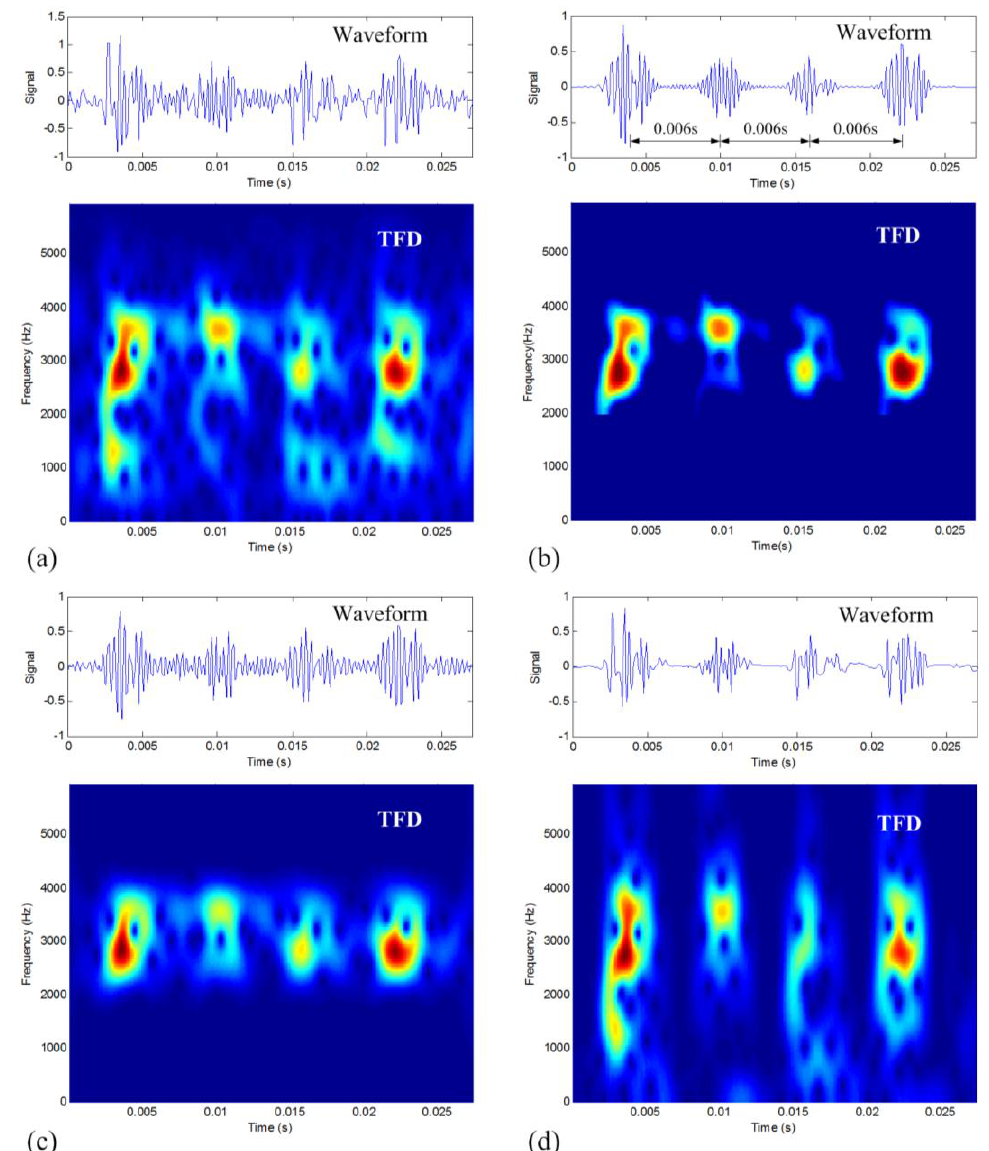
Figure 9. Denoising results of the inner-race defective vibration signal: ( a ) original raw signal; ( b ) the TFM-based denoising result; ( c ) band-pass filtering result; ( d ) DWT-based denoising